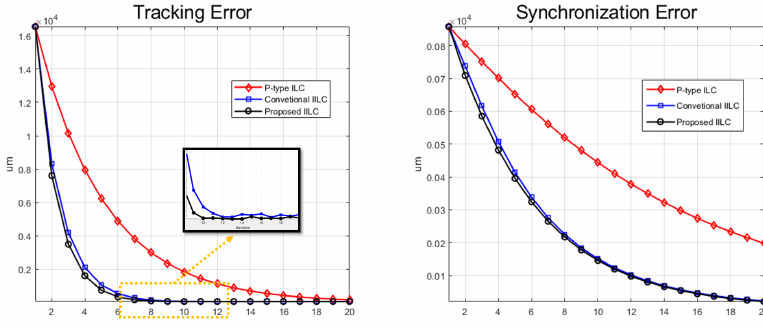
Figure 9. Track and synchronization with ILC